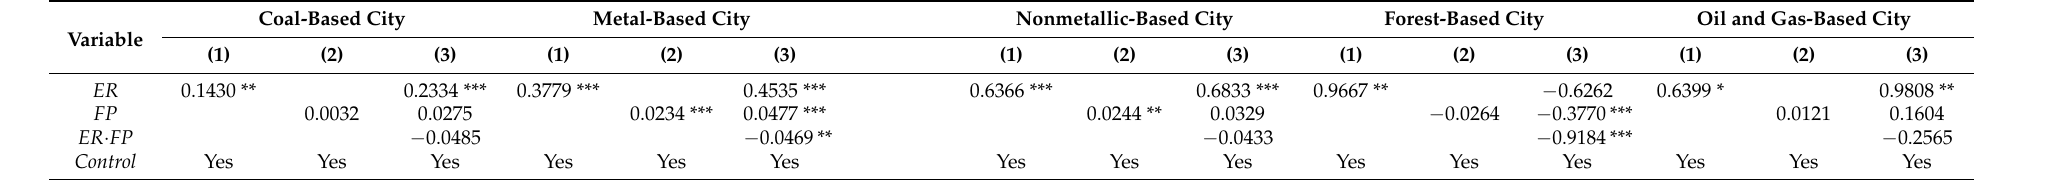
Table 6. Regression results by different resource types.